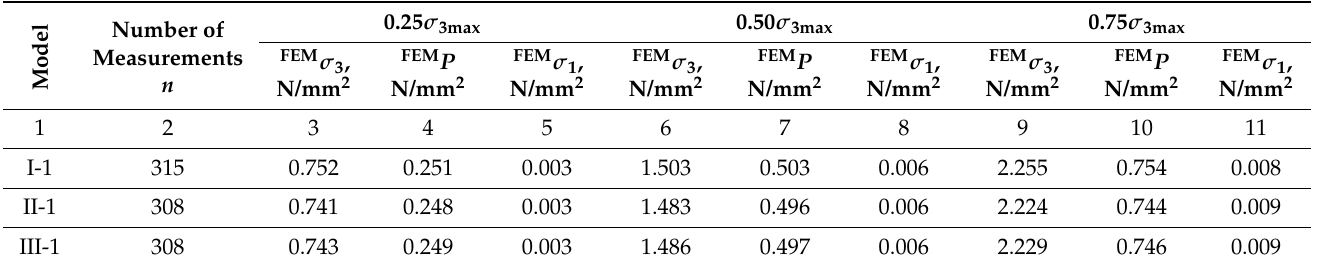
Table 9. FEM-based calculations for mean stresses P and σ 1 .